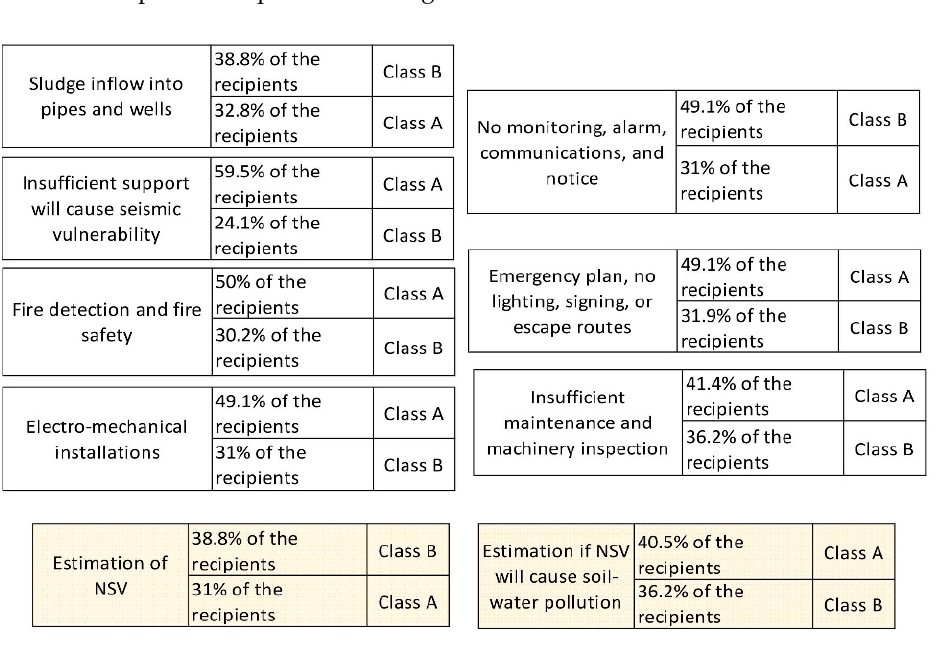
Figure 9. NSV of the WWTPs in the post-seismic period in Greece.